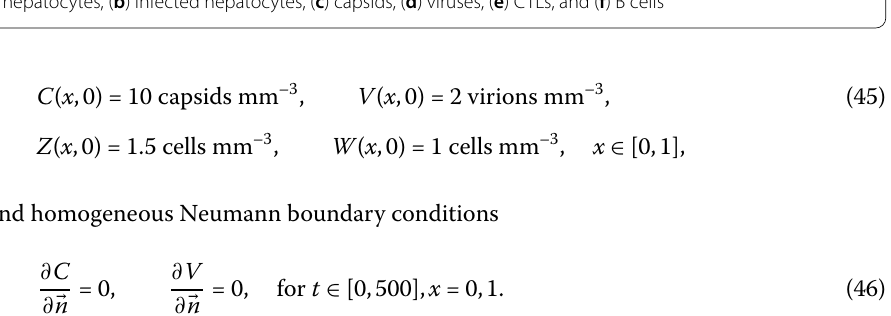
Figure 1 The numerical simulations of system (44)–(46) when R 0 ≤ 1. The infection-free equilibrium M 0 is globally asymptotically stable. The sub-figures show the spatiotemporal behaviors of ( a ) uninfected hepatocytes, ( b ) infected hepatocytes, ( c ) capsids, ( d ) viruses, ( e ) CTLs, and ( f ) B cells